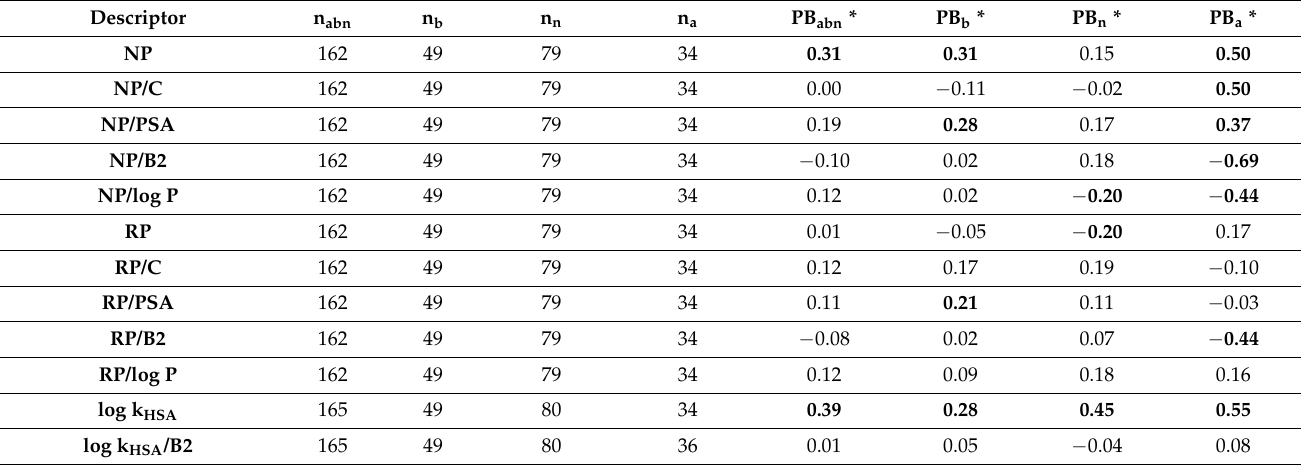
Table A1. Chromatographic data from TLC and HPLC experiments and their derivatives used in